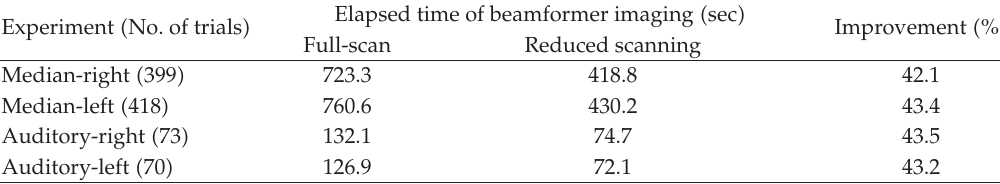
Table 1: Comparative total computing time (cid:2) in seconds (cid:3) of single trial analysis for di ff erent empirical data between conventional full-scan beamformer and reduced scanning beamformer with our proposed strategy. Source region with a total of 8,640 scanning points and a temporal window of 500 time samples were used. Experiments were conducted on a PC (cid:2) Intel Core 2 Duo CPU 2.4GHz, 32 bit OS, and 4GB RAM (cid:3)